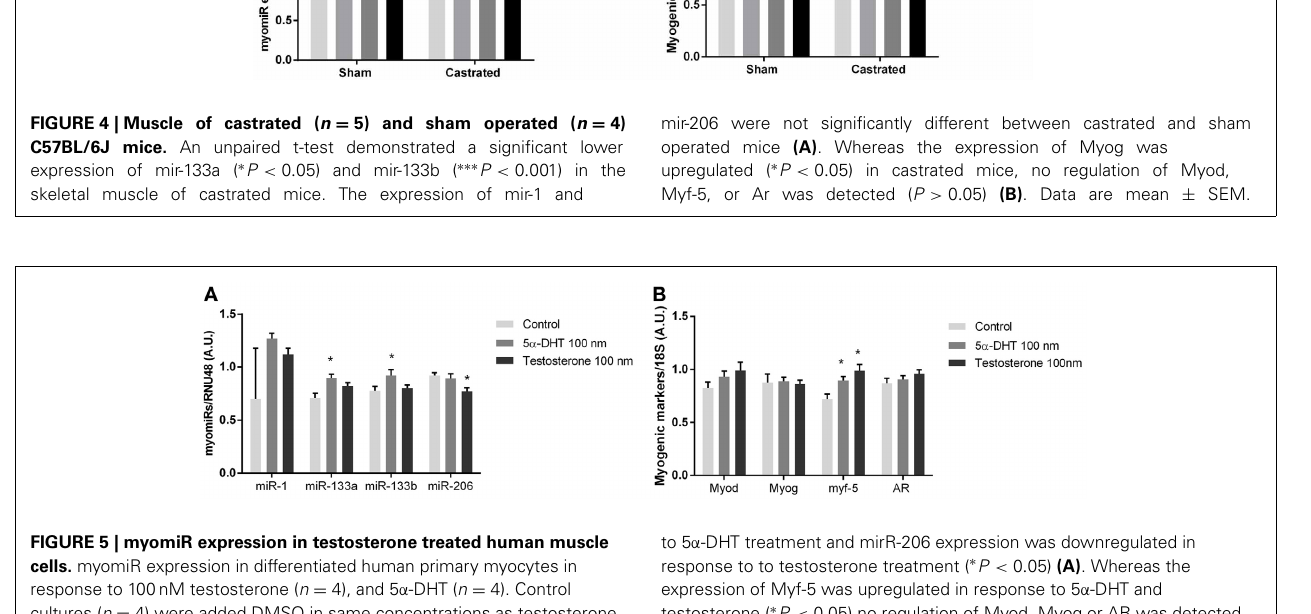
to 5 α -DHT treatment and mirR-206 expression was downregulated in response to to testosterone treatment ( ∗ P < 0 . 05) (A) . Whereas the expression of Myf-5 was upregulated in response to 5 α -DHT and testosterone ( ∗ P < 0 . 05) no regulation of Myod, Myog or AR was detected (B) . Data are mean ±